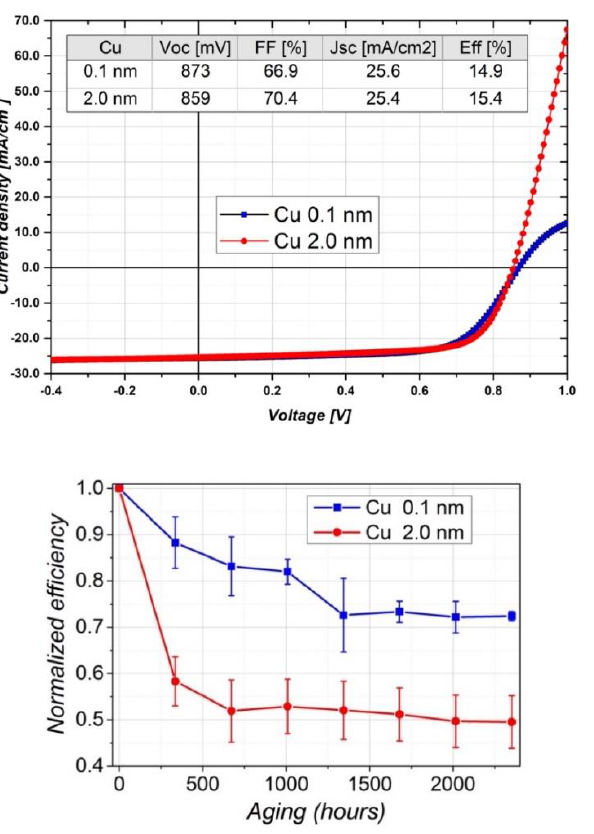
Figure 8. Comparison of CdTe solar cells with minimum amount and large amount of copper: ( top ) current-voltage characteristics, ( bottom ) efficiency versus time under 80 ◦ C and one sun illumination